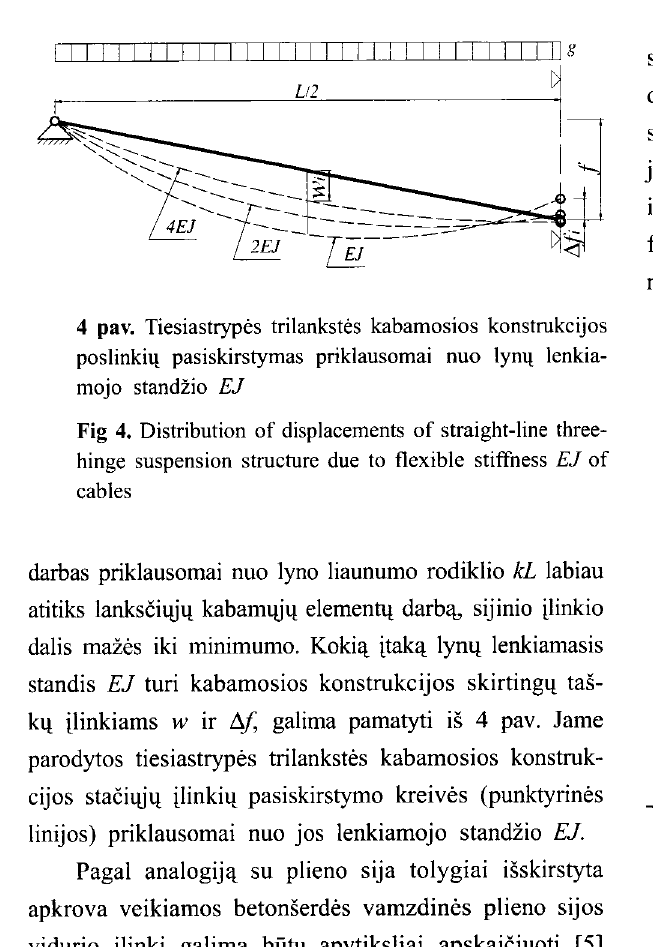
Fig 5. Theoretical deflection diagrams of the mid-span of straight-line hollow concrete-filled circular steel tubu lar members of three-hinge suspension structure ( quaters of the